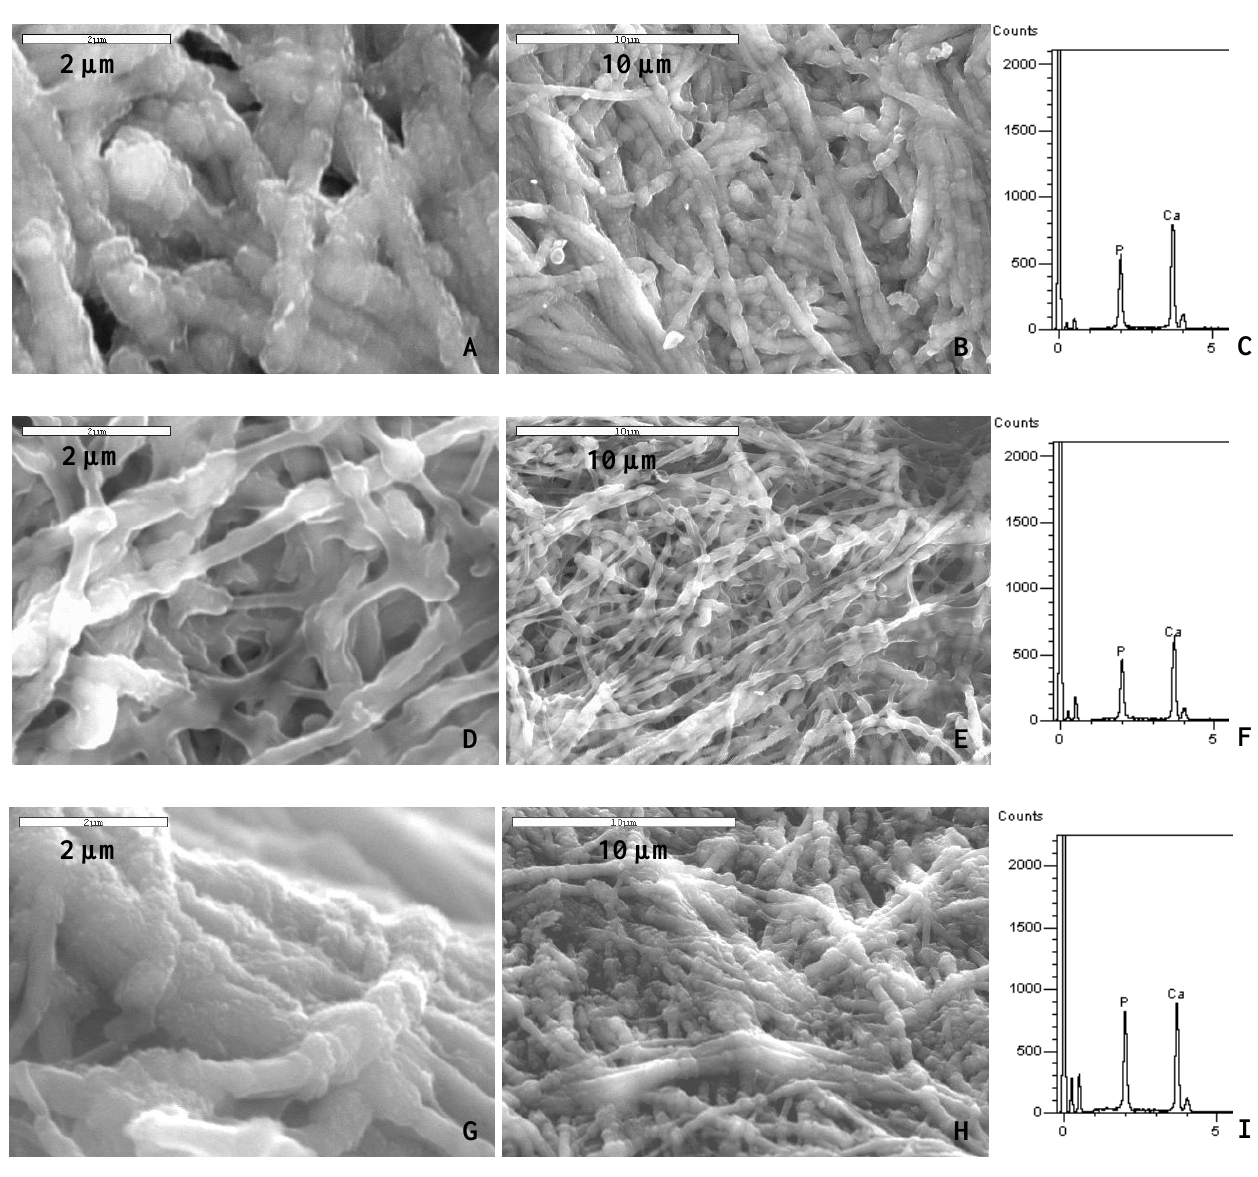
Figure 3. High and low magnification SEM images and EDS of the surface and inner-sections of PILP-mineralized collagen samples using 14-kDa poly-L-aspartic acid as the polymer directing agent. ( A , B ) SEM and ( C ) EDS of the surface of a mineralized collagen sponge treated with PILP solution containing 50 µg/mL PASP for 3 days. ( D , E ) SEM and ( F ) EDS of the inner-section of a mineralized collagen sponge treated with PILP solution containing 50 µg/mL PASP for 3 days. ( G , H ) SEM showing the inner-section of a mineralized collagen sponge treated with PILP solution containing 50 µg/mL PASP for 6 days. The external surface had the same appearance. ( I ) Corresponding EDS plot of the inner-section of PILP mineralized sample after 6